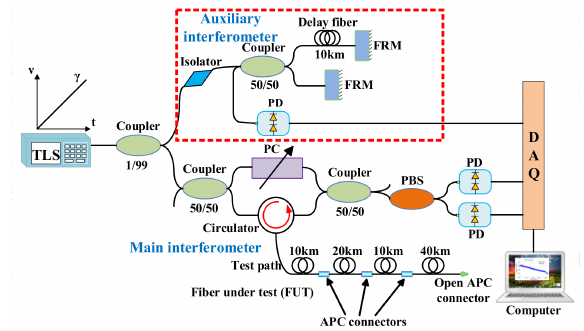
Figure 10. Experimental setup of the OFDR system using deskew filter method. TLS is tunable laser source. FRMs are Faraday rotating mirrors. PC is a polarization controller. PD is a photo-detector. PBS is a polarization beam splitter and DAQ is a data acquisition card (reprinted from Ding et al. [34] with permission of SPIE; copyright (2014)).